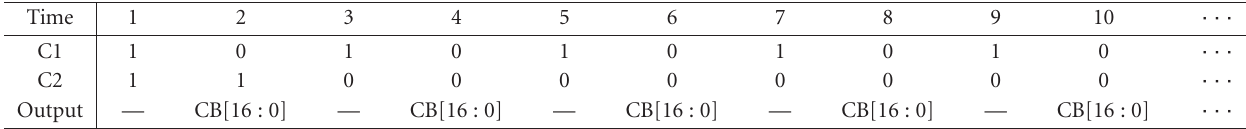
Table 6: The assignments of the control signals C1 and C2 in the CBSG.